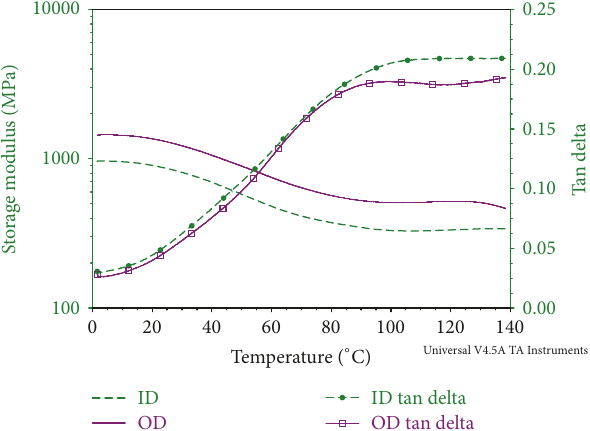
Figure 6: Storage modulus and tan 𝛿 are shown of OD and ID films.